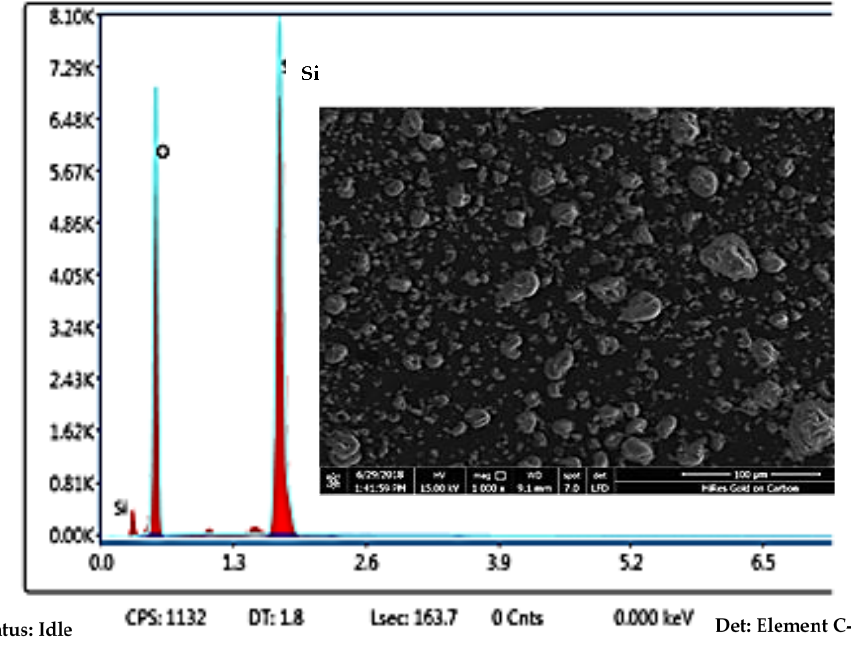
Figure 4. SEM-EDX analysis of the nanosilica.